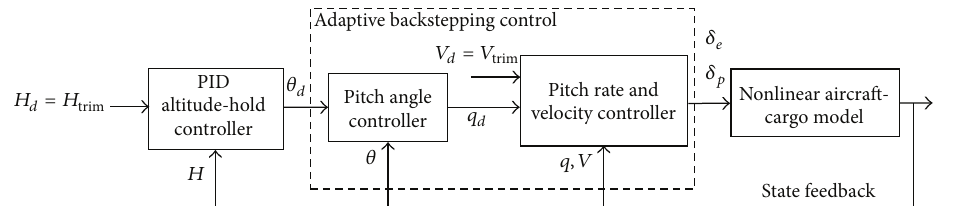
Figure 1: Autopilot control architecture with three layers of